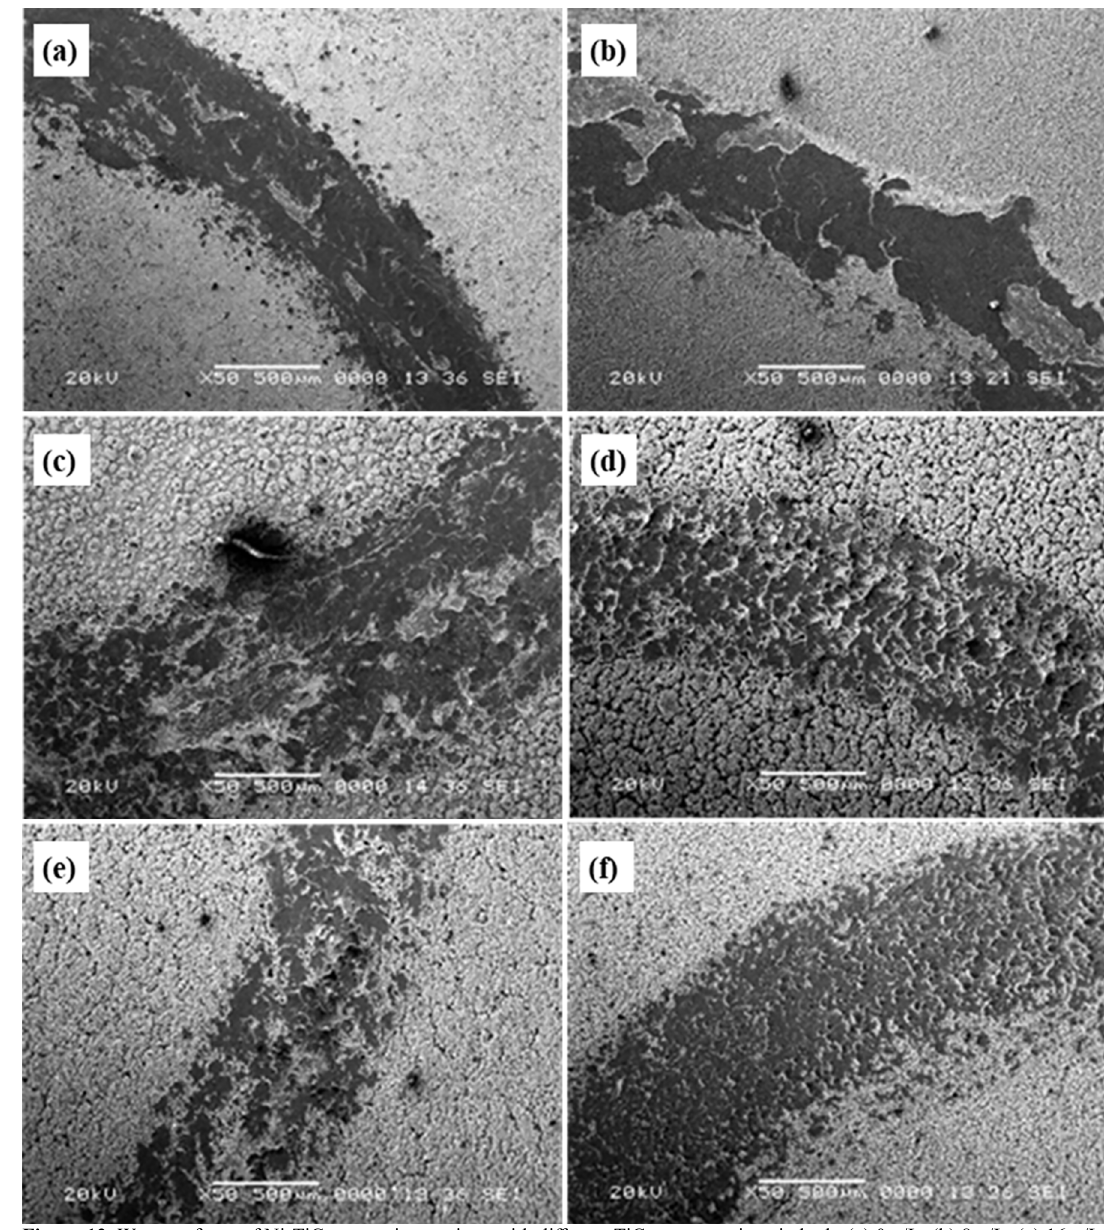
Figure 13. Worn surfaces of Ni-TiC composite coatings with different TiC concentrations in bath: (a) 0 g/L; (b) 8 g/L; (c) 16 g/L; (d) 24 g/L; (e) 32 g/L and (f) 40